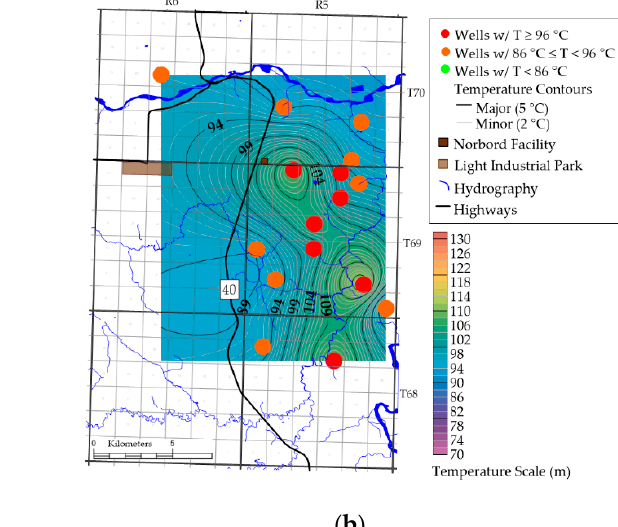
Figure 7. Contour maps of the drilling area for the Beaverhill Lake Group showing ( a ) depth to the top and ( b ) temperature at the top.